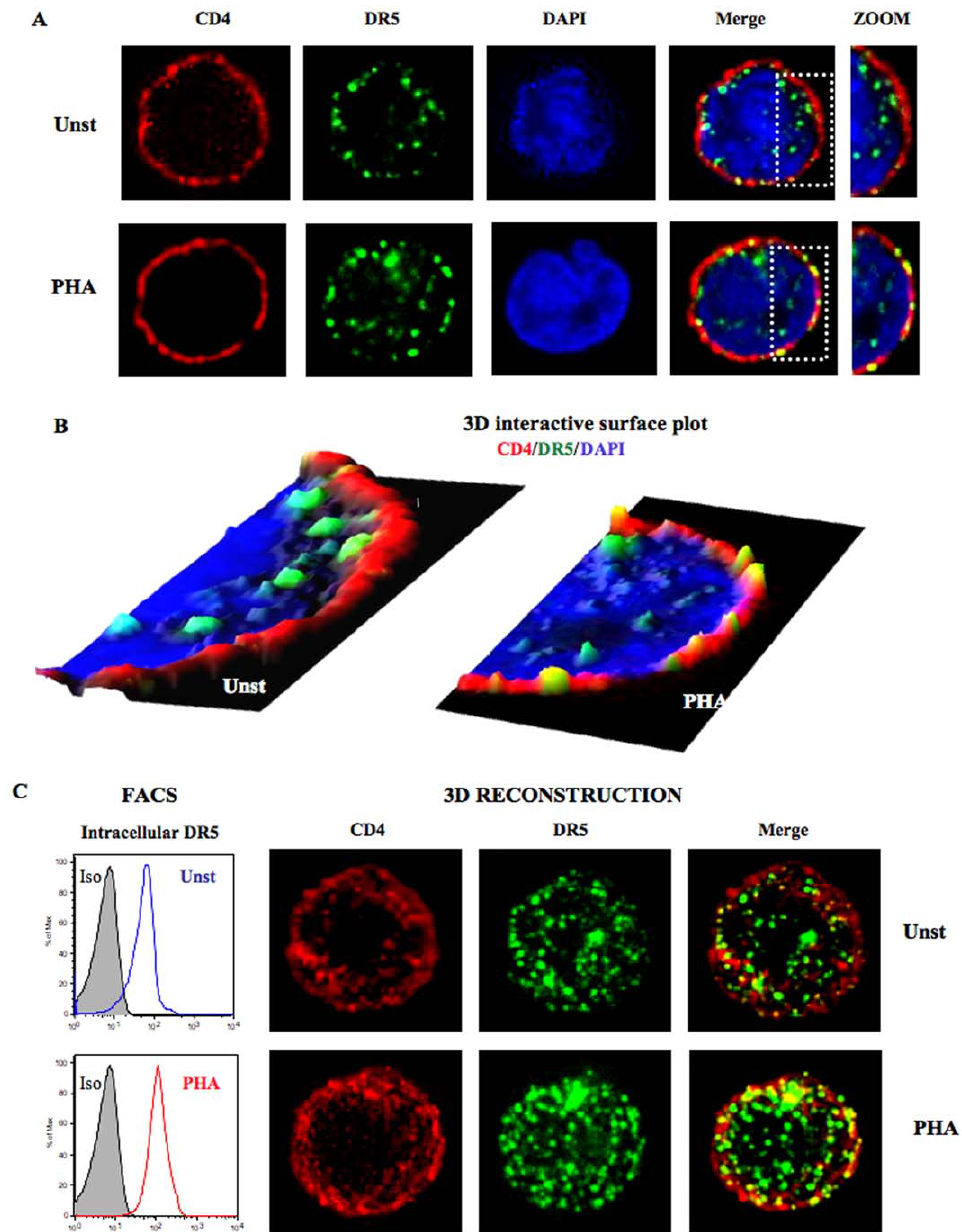
Figure 3. 3D microscopy study of DR5 expression by CD4 + T cells. A. CD4 + T cells were cultured overnight in presence or absence of PHA (2.5 m g/ml) and stained for DR5 (green), nuclear staining DAPI (blue) and CD4 (red) to study DR5 protein expression and localization. Unstimulated CD4 + T cells exhibited DR5 protein expression in the cytoplasm at close membrane proximity, defined by CD4 staining (upper panels). In contrast, PHA-activated CD4 + T cells expressed intracellular and membrane DR5. DR5/CD4 colocalization appears in yellow. To better visualize DR5 localization, a zoom of the dotted line defined zone from CD4/DR5/DAPI overlay picture was added (extreme right panels). B. DR5 analysis using 3D interactive surface plot. Previous 3D microscopy pictures were analyzed using 3D interactive surface plot. Representation allowed a clear visualization of intracellular DR5 (green) and membrane CD4 (red). Unstimulated CD4 + T cells harbored only intracellular DR5 inside the CD4 (membrane) delimitation. PHA stimulation of CD4 + T cells induced the export of DR5 protein at the surface delineated by CD4 staining (red) but some DR5 also remained intracellular. Yellow spots represent DR5/CD4 colocalization. C. FACS analysis of intracellular staining of DR5 and compilation of all plans from previous microscopic images were used to perform 3D reconstruction. This representation illustrates the difference of DR5 quantity between unstimulated and activated CD4 + T cells. PHA-stimulated cells expressed more DR5 (green) and show more colocalization (yellow) with CD4 than unstimulated cells. Each picture is representative of the vast majority of the observed cells on the slides.